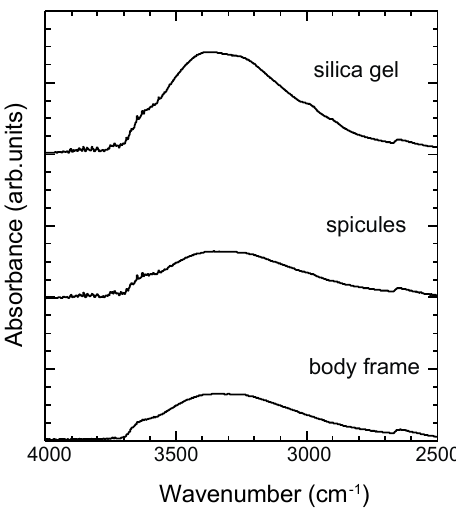
Figure 9. ATR-IR spectra ( ν = 2500–4000 cm − 1 ) for body frame, spicules, and silica gel. The spectrum of silica glass had no peaks in this wavenumber region.